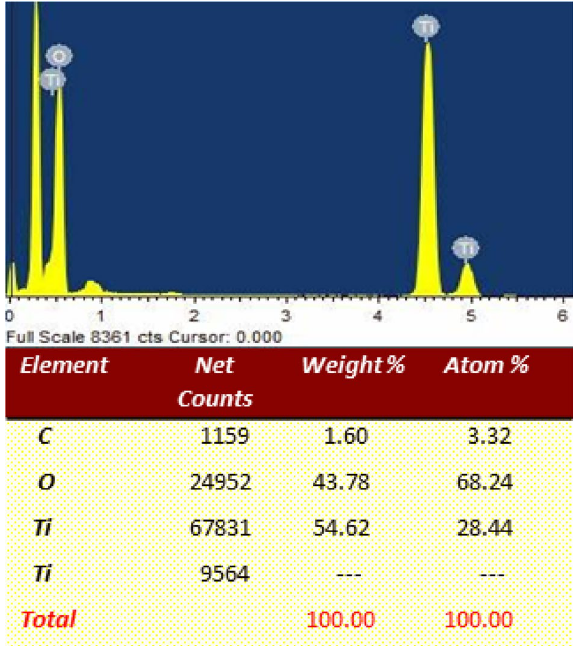
Figure 11. EDAX spectrum of NT1.